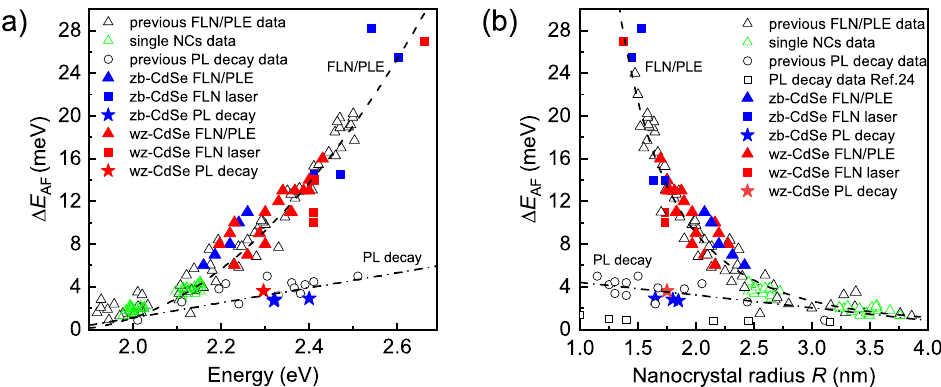
Figure 3. ( a ) Comparison of ∆ E AF values determined by the FLN/PLE and PL decay methods (stars) for zb-CdSe (blue) and wz-CdSe (red) NCs. The FLN/PLE data obtained using excitation by the Hg lamp and the Ar ion laser are shown by triangles and squares, respectively. Open black and green trian- gles show the previous results of FLN/PLE [23,25–27] and single NCs studies [34], respectively. Open circles show previous results from PL decay studies [27,28,31,32]. For the FLN/PLE studies, the en- ergy corresponds to the excitation/detection energy. For the PL decay studies, the energy corresponds to the maximum of the PL spectrum. The FLN/PLE data follow the trend ∆ E AF ( E ) = α E ( E − E g ) 2 with the band gap energy E g = 1841 meV of wz-CdSe, and α E = 0.44 × 10 − 4 meV − 1 . ( b ) Depen- dence of the ∆ E AF values presented in panel ( a ) on the NC radius R . The joint FLN/PLE data are complemented by data points from Ref. [24] which lack information about the excitation energy. For the ∆ E AF determined from the PL decay studies, we use the nominal NC radii reported in Refs. [27,28,31,32]. Empty squares in panel ( b ) show the PL decay data from Ref. [30]. The FLN/PLE data follow the trend ∆ E AF ( R ) = α R ( a B / R ) 3 with the exciton Bohr radius a B = 5.6 nm of CdSe, and α R = 0.44 meV. Dash-dotted lines in panels ( a , b ) are guides for the eye for the PL decay